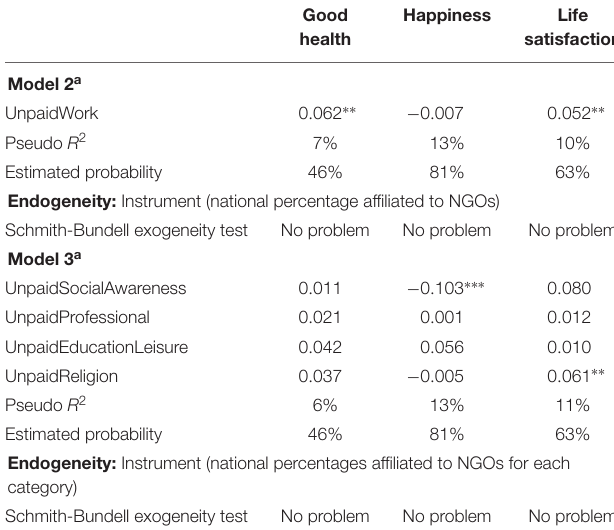
TABLE 3 | Estimations of wellbeing indicators: Model 2 and Model 3 (Logit: TABLE 2 | Estimations of wellbeing indicators: Model 1 (Logit: dy/dx). Good health Happiness Life satisfaction